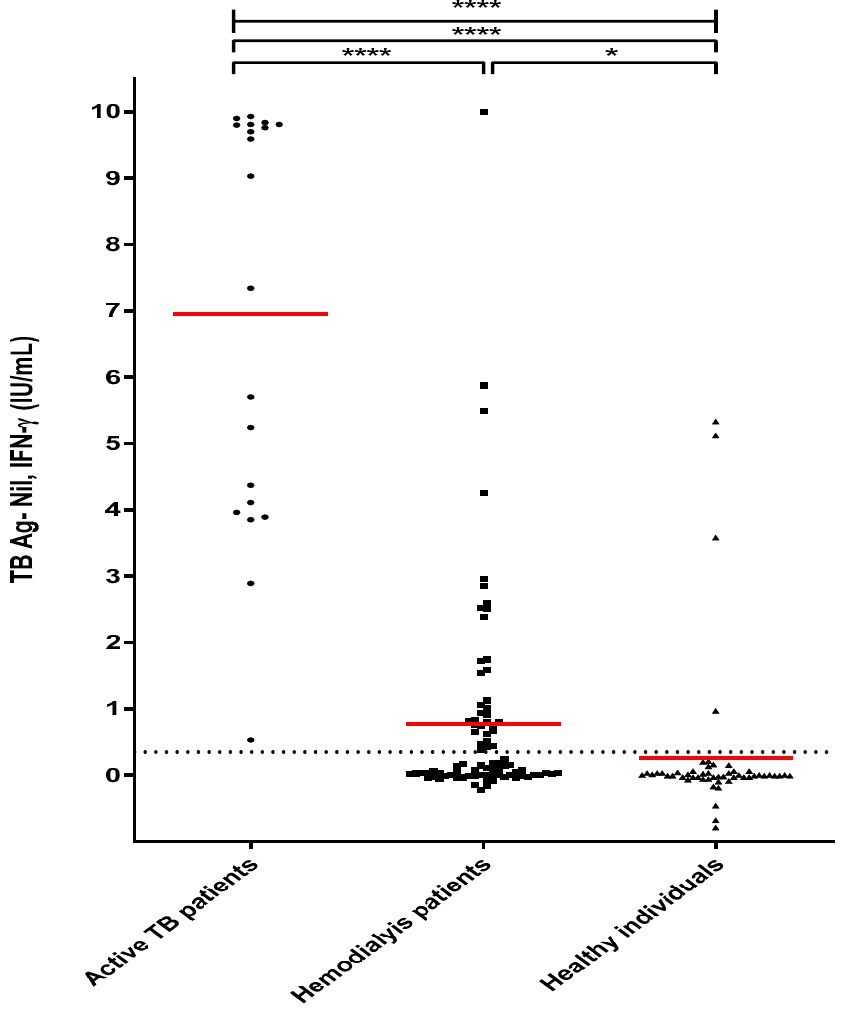
Figure 1. MTB-specific Ag stimulated IFN- γ levels in Active TB patients, hemodialysis patients, and healthy individuals. Note: Whole blood of study subjects (active TB patients group, hemodialysis patients (HD) group, and healthy individuals (HI) group) were stimulated with MTB-specific antigens (early secretory antigen target 6, culture filtrate protein 10, and TB 7.7) for 24 h. The red line in the graph represents the mean value for each group. Active TB patients ( n = 20); hemodialysis patients ( n = 83), healthy individuals ( n = 52); * p < 0.05, **** p < 0.0001. 3.4. Comparison of Results from MTB-Specific Ag Stimulated IFN- γ Levels and PHA-Stimulated IFN- γ Levels between Hemodialysis Patients and Healthy Individuals The correlation coefficient graph of MTB-specific Ag stimulated IFN- γ levels and PHA-stimulated IFN- γ levels is shown in Figure 3. A total of 85% of patients with active tuberculosis had PHA-stimulated IFN- γ levels below 10 (Figure 3A). Of 83 HD patients, 33 (39.8%) had PHA-stimulated IFN- γ levels below 10, while14 (41.2%) of HD patients with LTBI and 19 (38.8%) non-LTBI HD patients, respectively, also had PHA-stimulated levels below 10 (Figure 3B). On the other hand, none of the healthy individuals had PHA- stimulated IFN- γ levels below 10 (Figure